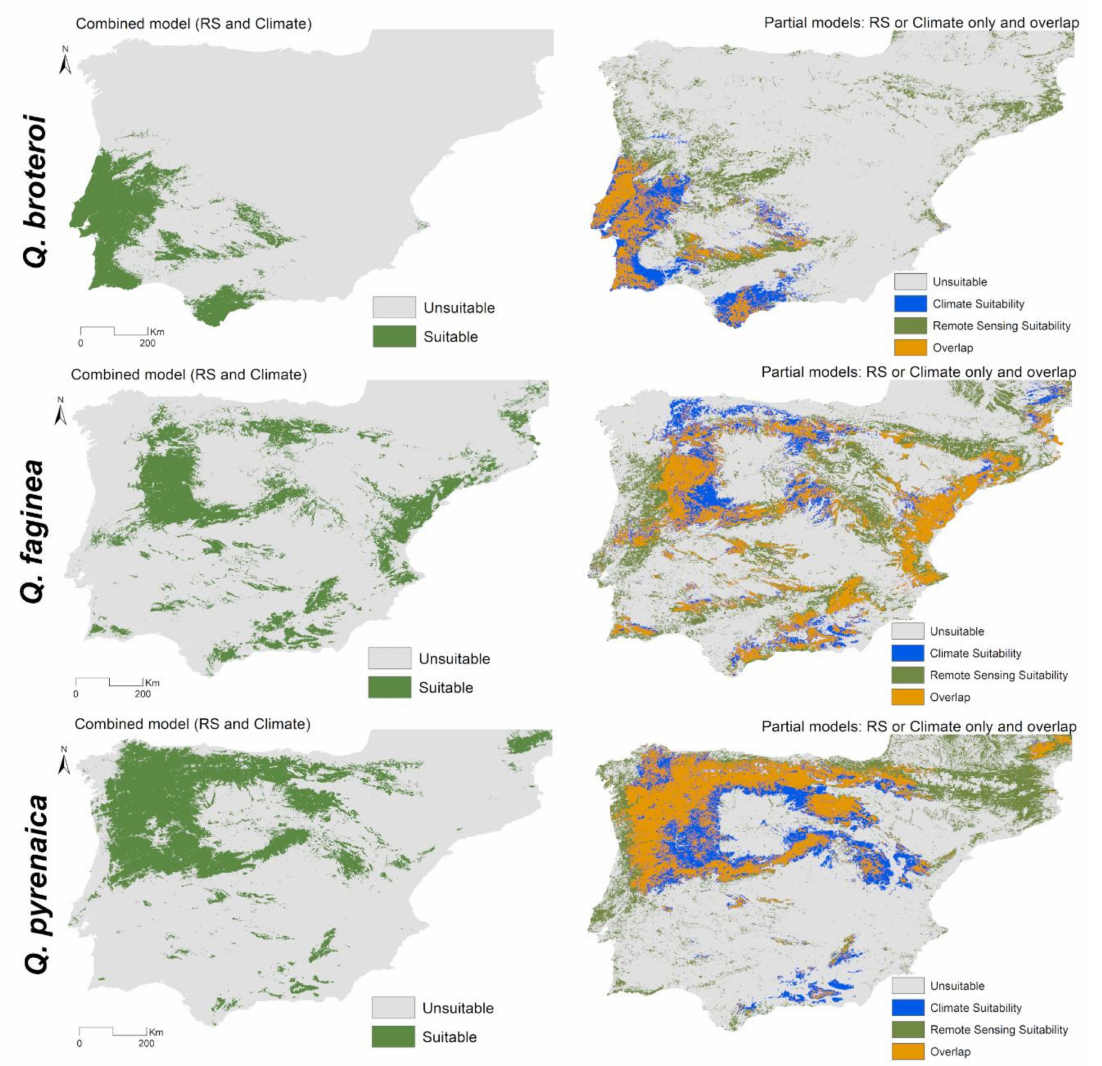
Figure A3. Combined models (remote sensing—RS and climate) (Left) and partial models (RS or climate and overlap) (Right) for Q. broteroi, Q. faginea and Q. pyrenaica